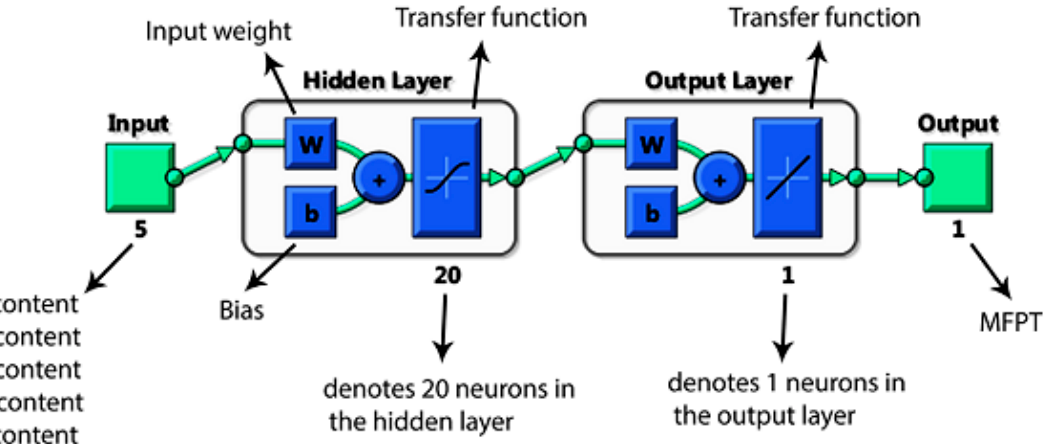
Figure 6. The schematic architecture of the ANN model that was used to predict the mean fireproofing time of the intumescent flame-retardant coating. Adapted with permission from ref. [99]. Copyright 2013 Fire Safety Journal.